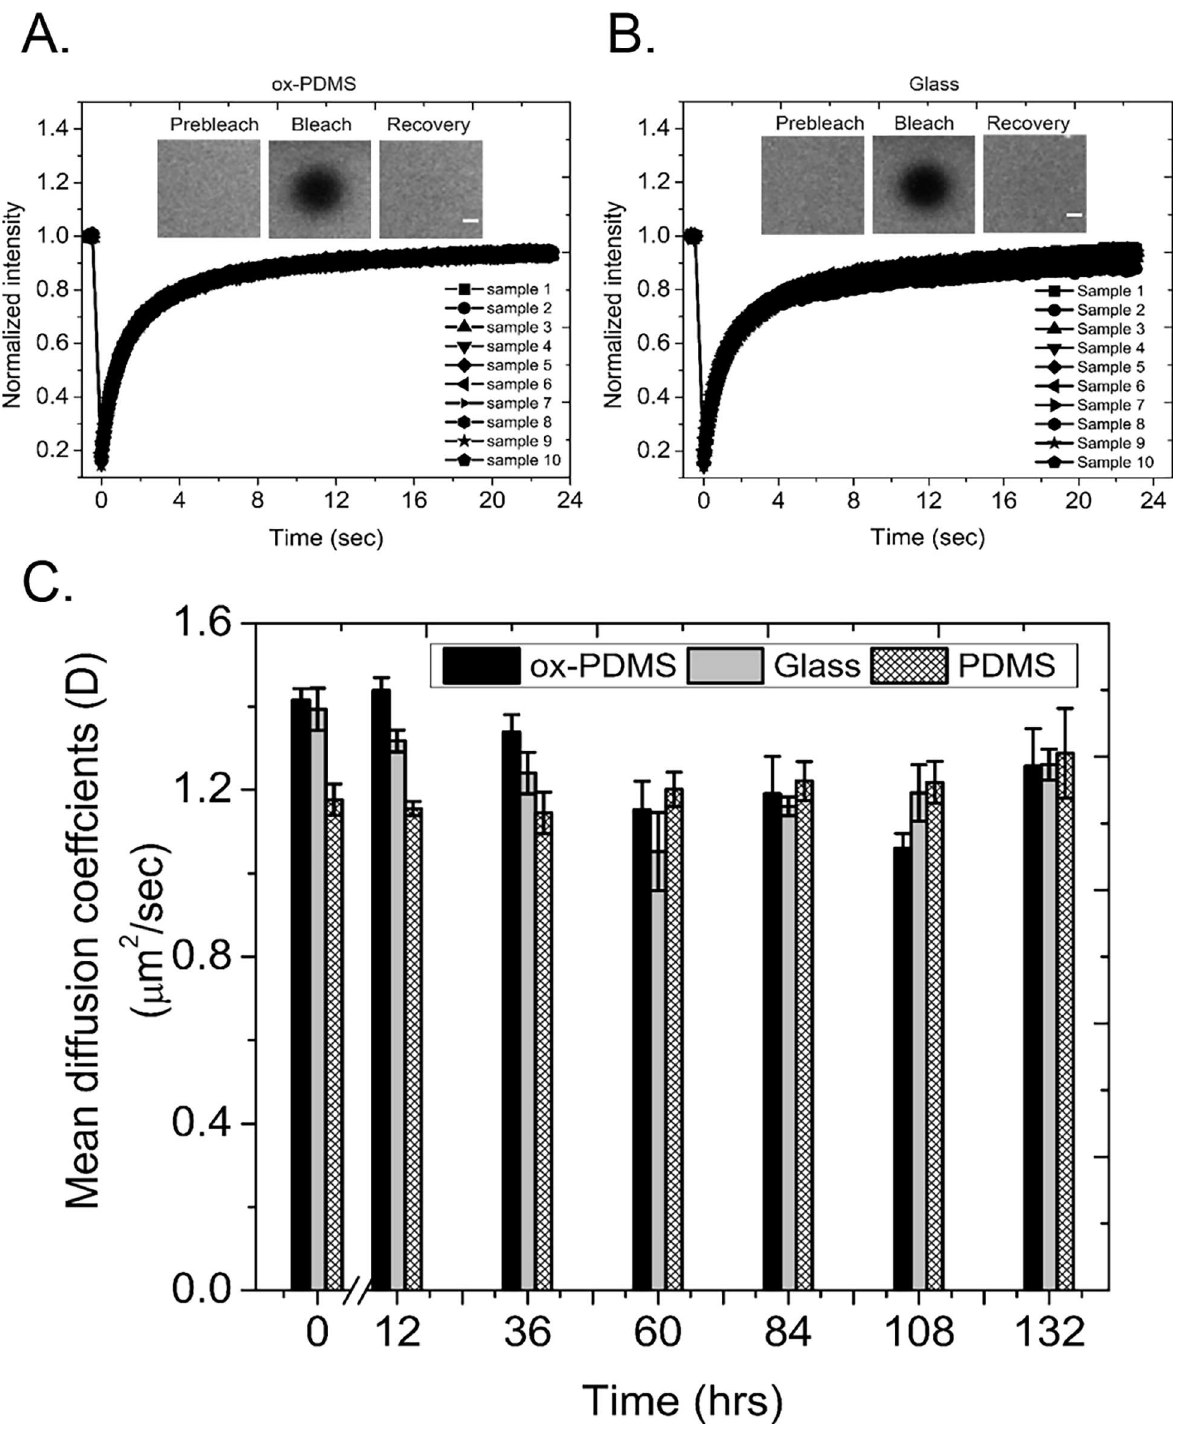
Fig 6. Measurement of the diffusive mobility of lipids on the lipid layers. Plot of the fluorescence recovery curves on, A) ox-PDMS, and B) glass, immediately after preparation of the lipid bilayers.Each plot shows recovery curves from FRAP measurements on ten different locations.The recovery curves are highly reproducible. Insets are representative images before the bleachpulse, the first image after the bleach pulse, and the final image of the time series at 24 seconds. Scale bars 2 μ m. C) Plot of the diffusion coefficientversus the time since preparation of the lipid layer. The black bars are for the bilayers on ox-PDMS, the gray bars are for bilayers on glass, and the cross-hatched bars are for monolayers on native PDMS. The diffusioncoefficient does not change significantly for the lipid monolayers over the course of 132 hours. The diffusion coefficient of the lipids in the bilayer on ox-PDMS and glass were similar and higherthan